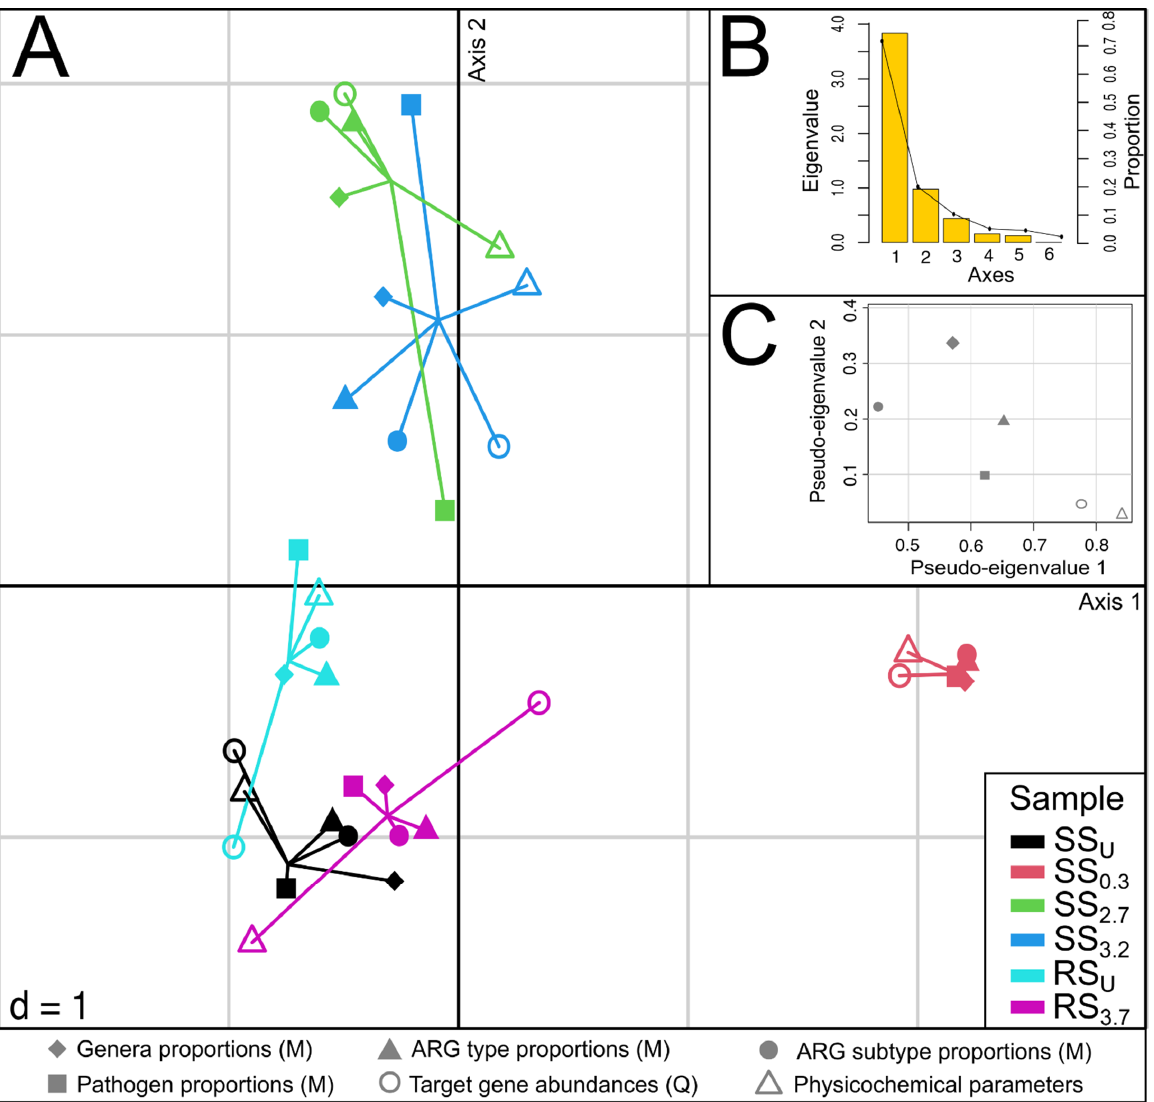
Figure 6. Multiple co-inertia analysis results based on six sediment-specific datasets (microbial genera and pathogen proportions in prokaryotic community, antibiotic resistance type and ARG subtype proportions, ARG gene abundances, and sediment physicochemical parameters). ( A ) A plot of the first two components in sample space. Each sample is represented by a shape where the six datasets for each sample are connected by lines to a center point (global score). ( B ) A scree plot of absolute eigenvalues (bars) and the proportions of variance for the eigenvectors (line). ( C ) A plot of data weighting space that shows the pseudo-eigenvalues space of all datasets indicating how much variance of an eigenvalue is contributed by each dataset.